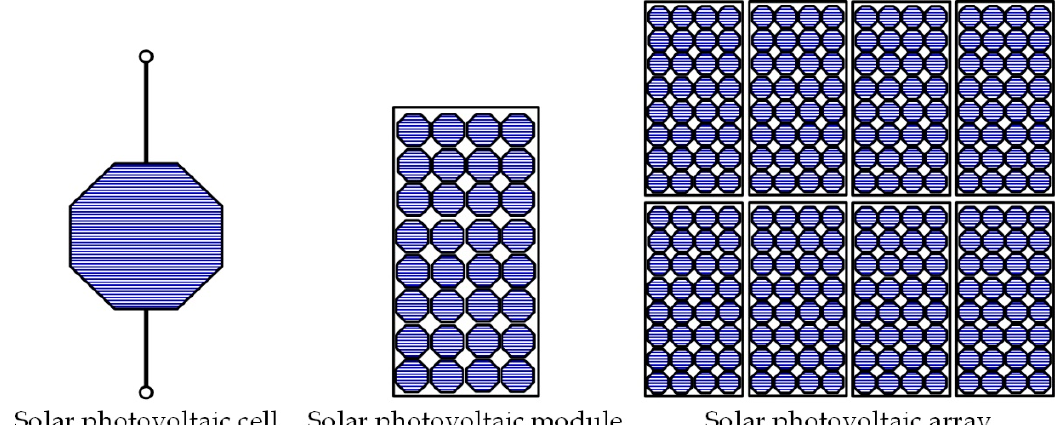
Table 2. Specifications of a single SPVM. Figure 3. The schematic diagram of SPVC, SPVM, and a solar photovoltaic array.